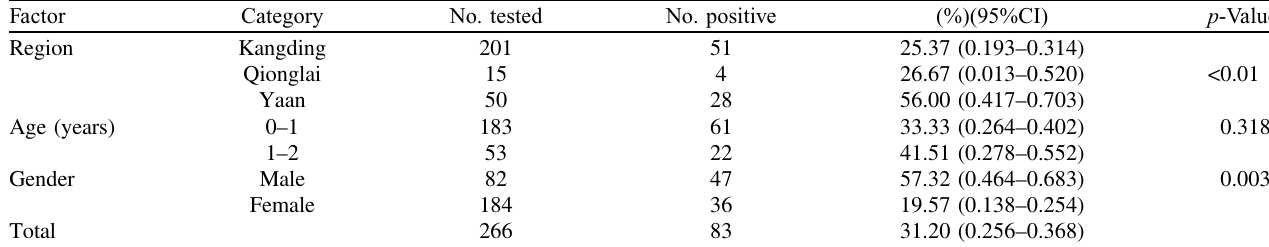
Table 1. Factors associated with prevalence of Enterocytozoon bieneusi in Tibetan pigs in southwestern China.